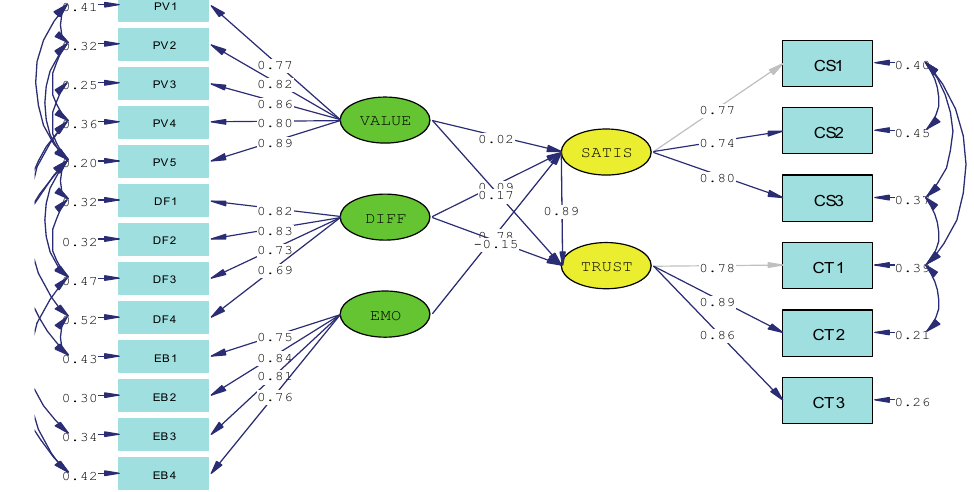
Fig. A.1 . Recursive - Path diagram of structural